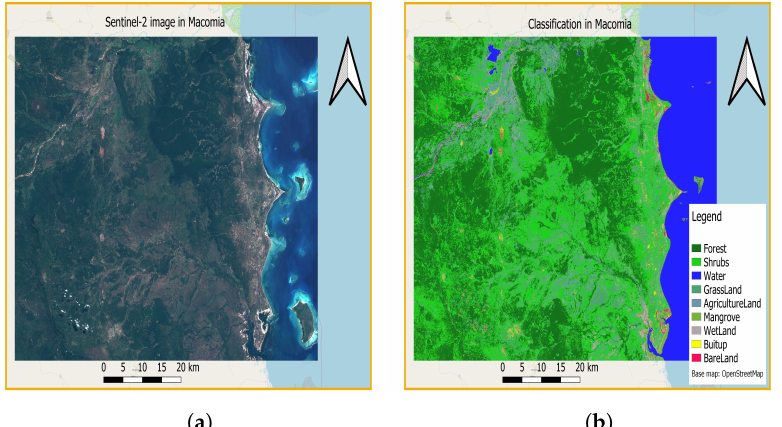
Figure 10. Classification results in Macomia. On the left we can see the original image, and on the right the respective classification results. ( a ) S2 image, 2 December 2018. ( b ) Classification results.